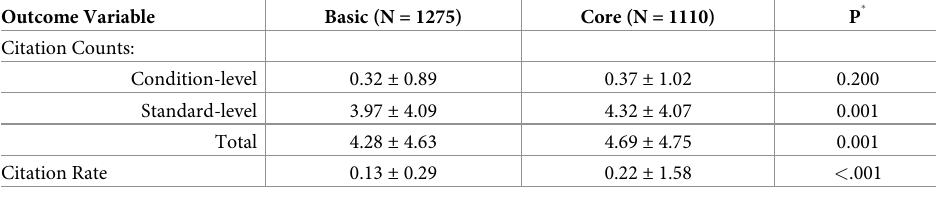
Table 2. Comparison of survey outcomes between Basic and Core surveys in the original unmatched sample. All outcomes are reported as mean ± standard